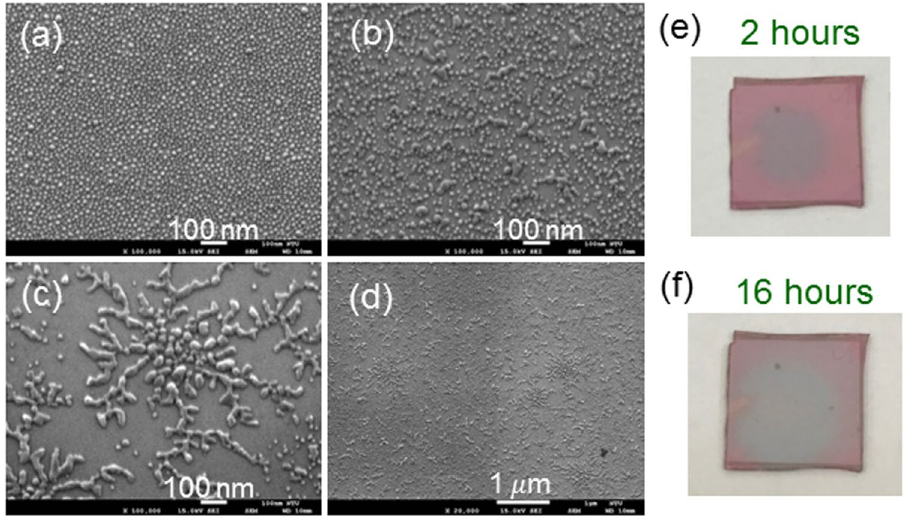
Figure 9. ( a–c ) SEM images of a fresh Ag NP sample on GaN, its Ag NP structures after the illuminations of the 395-nm LED for 2 and 16 hours, respectively, when ambient air humidity is ~40%. ( d ) SEM image in the case of 16-hour illumination with a smaller magnification. ( e,f ) Photographs of the samples with 2- and 16-hour illuminations, respectively.